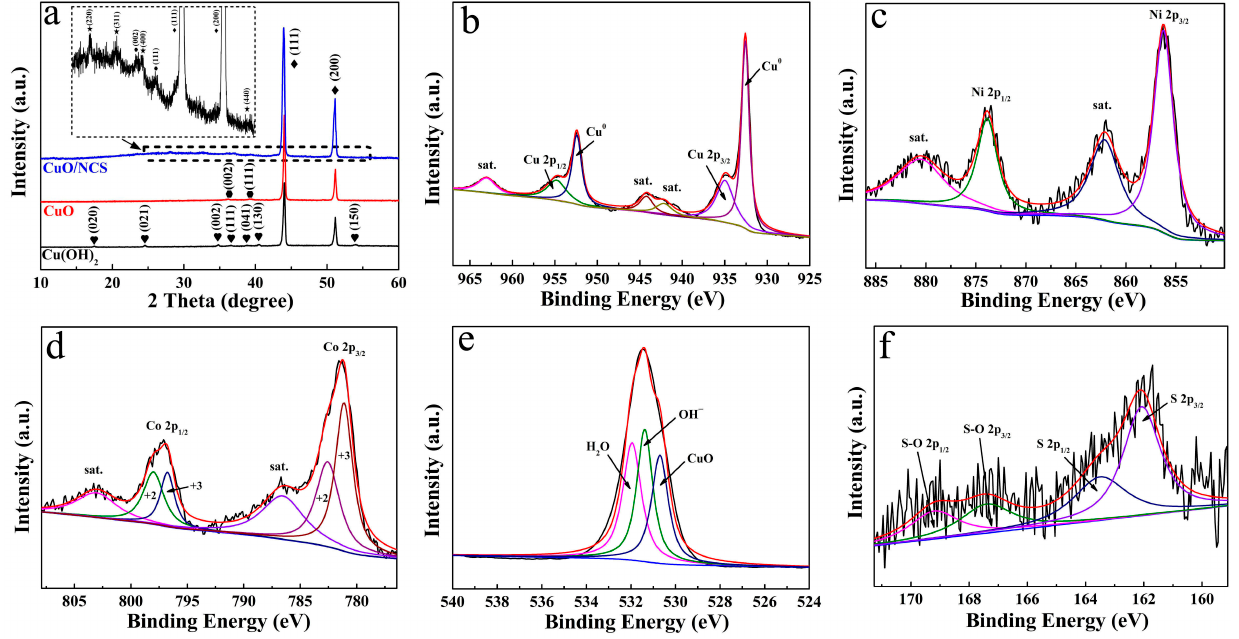
Figure 3. XRD patterns of Cu(OH) 2 , CuO, and CuO/NCS ( a ). XPS spectra of ( b ) Cu 2p, ( c ) Ni 2p, ( d ) Co 2p, ( e ) O 1s, and ( f ) S 2p for CuO/NCS.